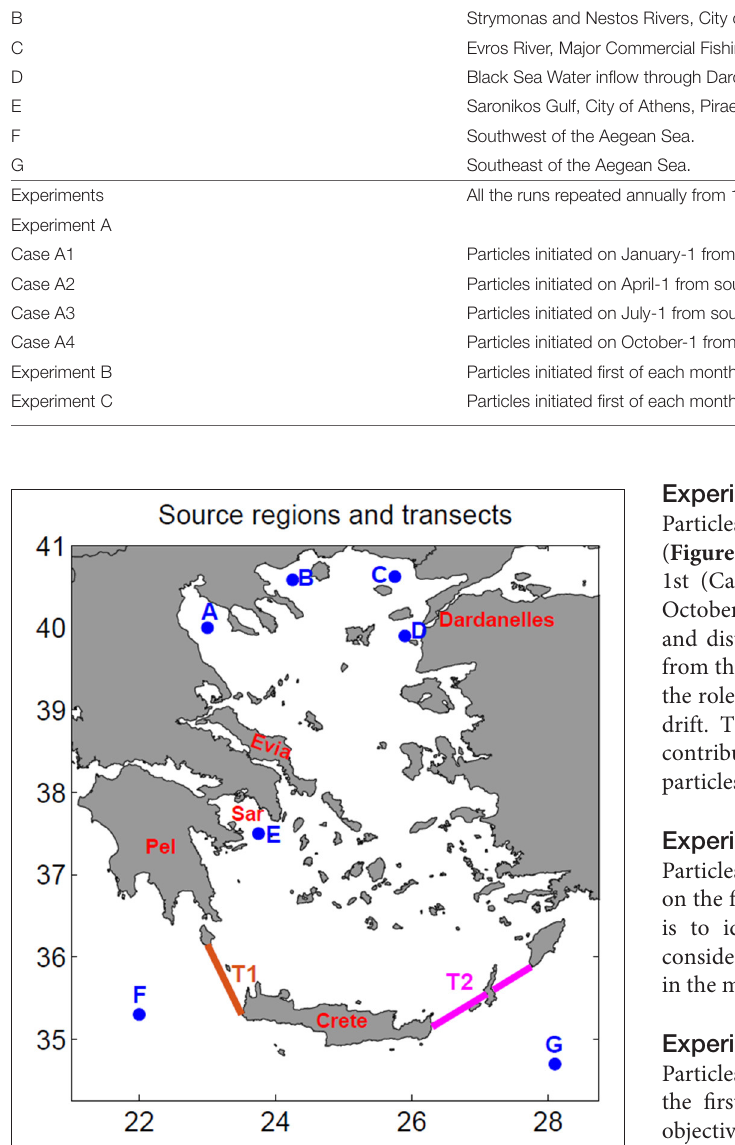
FIGURE 2 | Letters A,B,C,D,E,F, and G denote considered source regions of floating litter. Two transects, marked as T1 (orange) and T2 (magenta) lines, are used to compute the floating litter exchange between the Aegean Sea and the Eastern Mediterranean